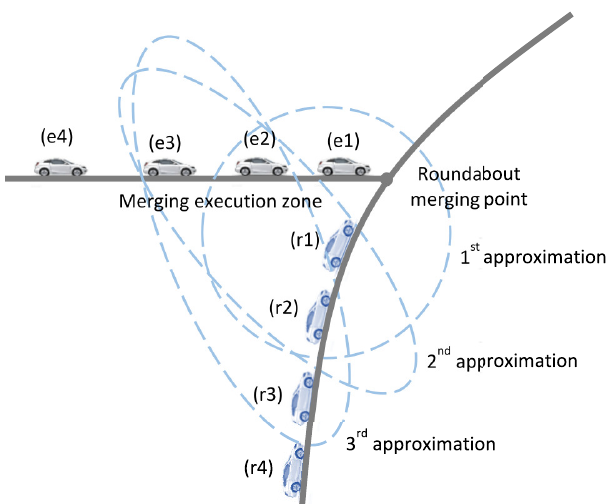
Figure 4. Successive optimization of vehicles (blue dashed regions) in a receding horizon approach in the lower level